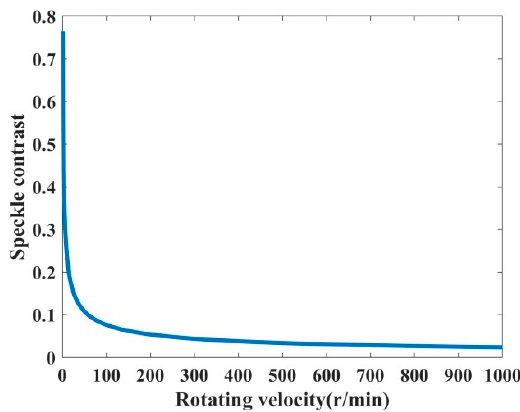
Figure 10. Relationship of speckle contrast with rotational velocity.